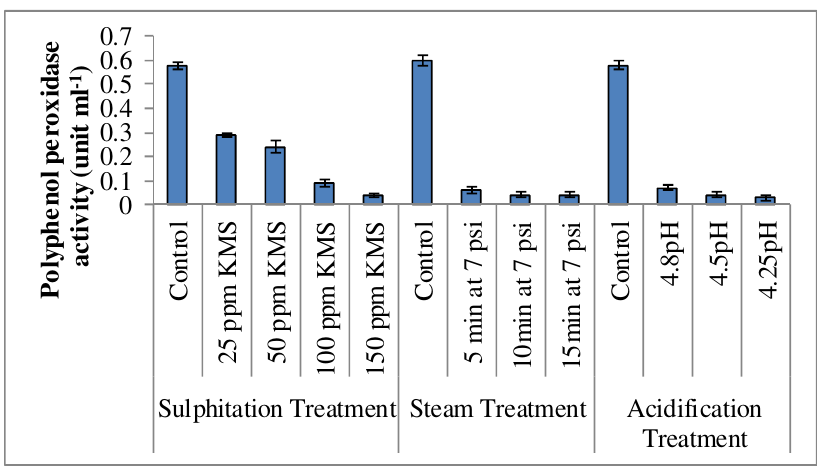
Figure 4. Effect of sulphitation, steam, and acidification treatments on the polyphenol oxidase activity (the numerical mean and the error bars (S.E) of triplicates (n = 3) are displayed in vertical bars).